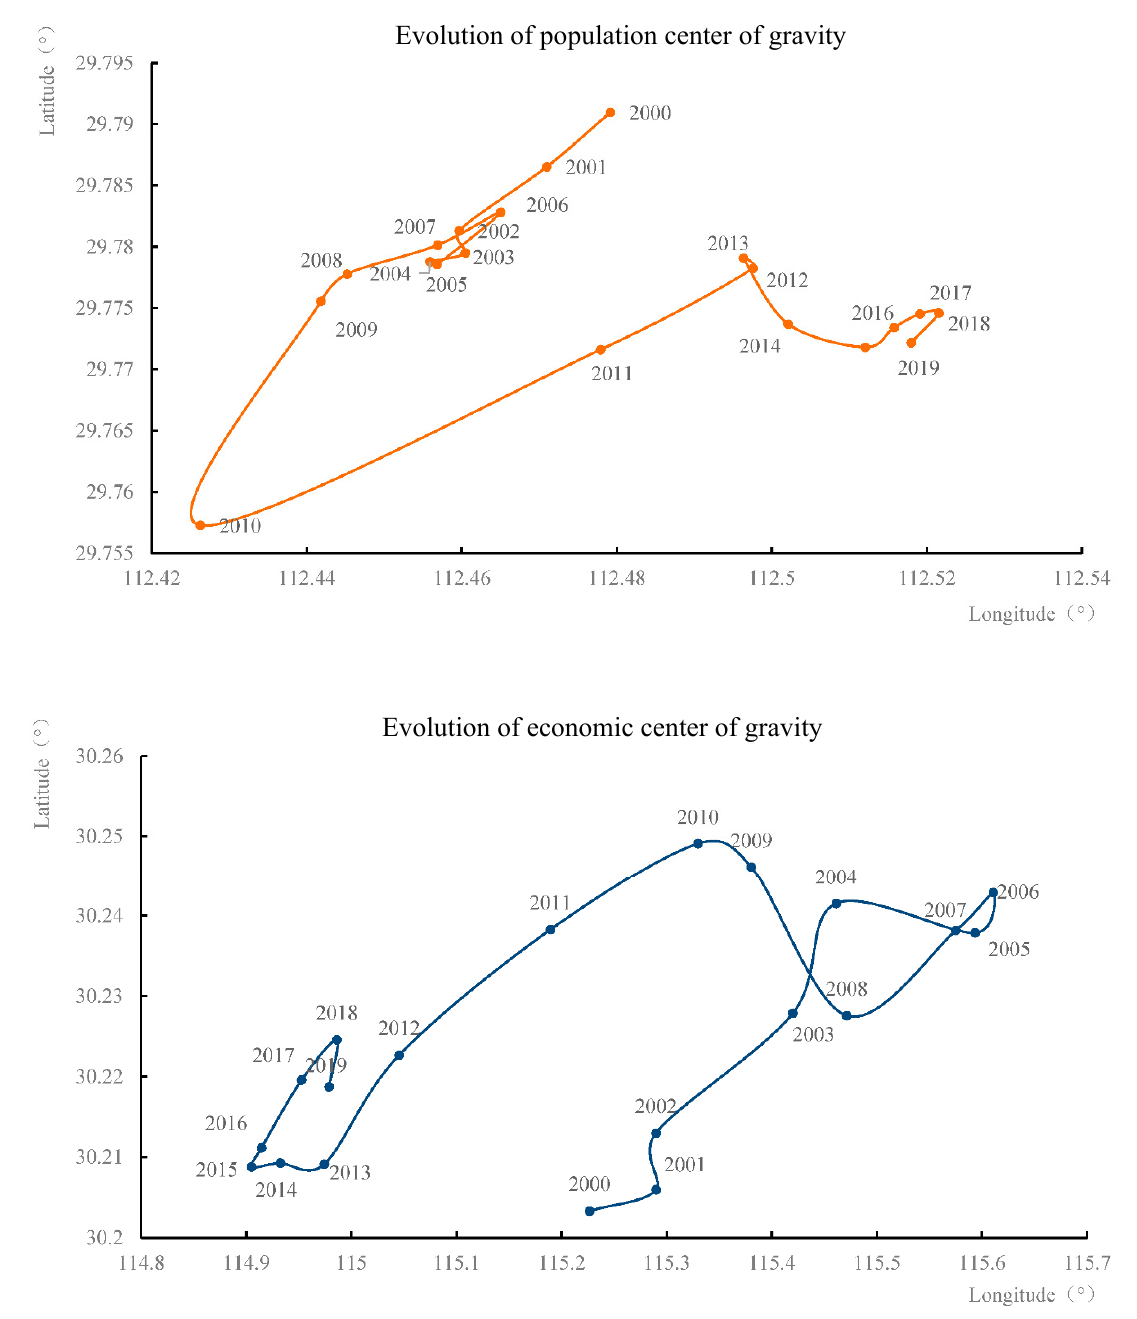
Figure 5. Evolution of population and economic center of gravity from 2000 to 2019.